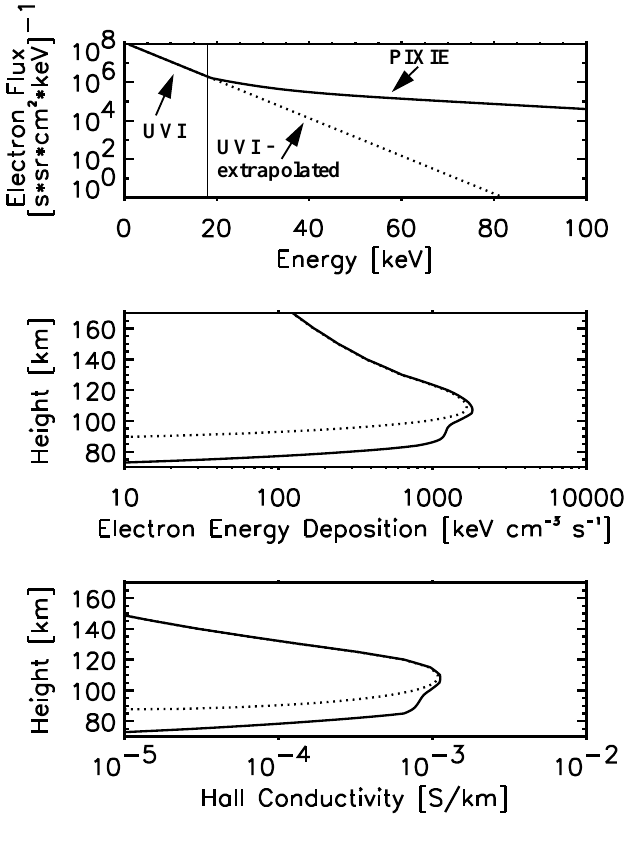
Fig. 16. (a) An example of a typi- cal precipitating electron energy spec- trum derived using UVI data at lower electron energies (solid line) and then PIXIE data at higher energies (solid line) and an extrapolation of the UVI derived electron spectrum (dashed line). (b) Height profiles showing the electron energy deposition for the two situations presented in (a). (c) Height profiles of the Hall conductivity for the two situa- tions presented in